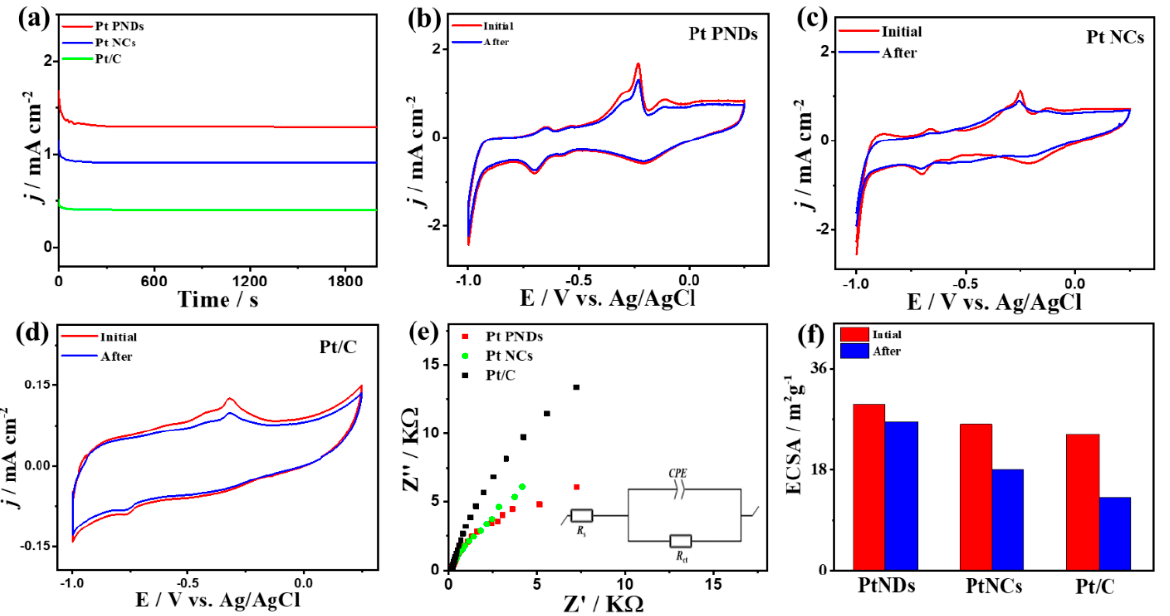
Figure 6. ( a ) CA tests measured on Pt NDs, Pt NCs, and Pt/C in CO-saturated 0.1 M KOH. CV curves measured after CA on ( b ) Pt NDs, ( c ) Pt NCs, and ( d ) Pt/C. ( e ) EIS and ( f ) ECSA stability.